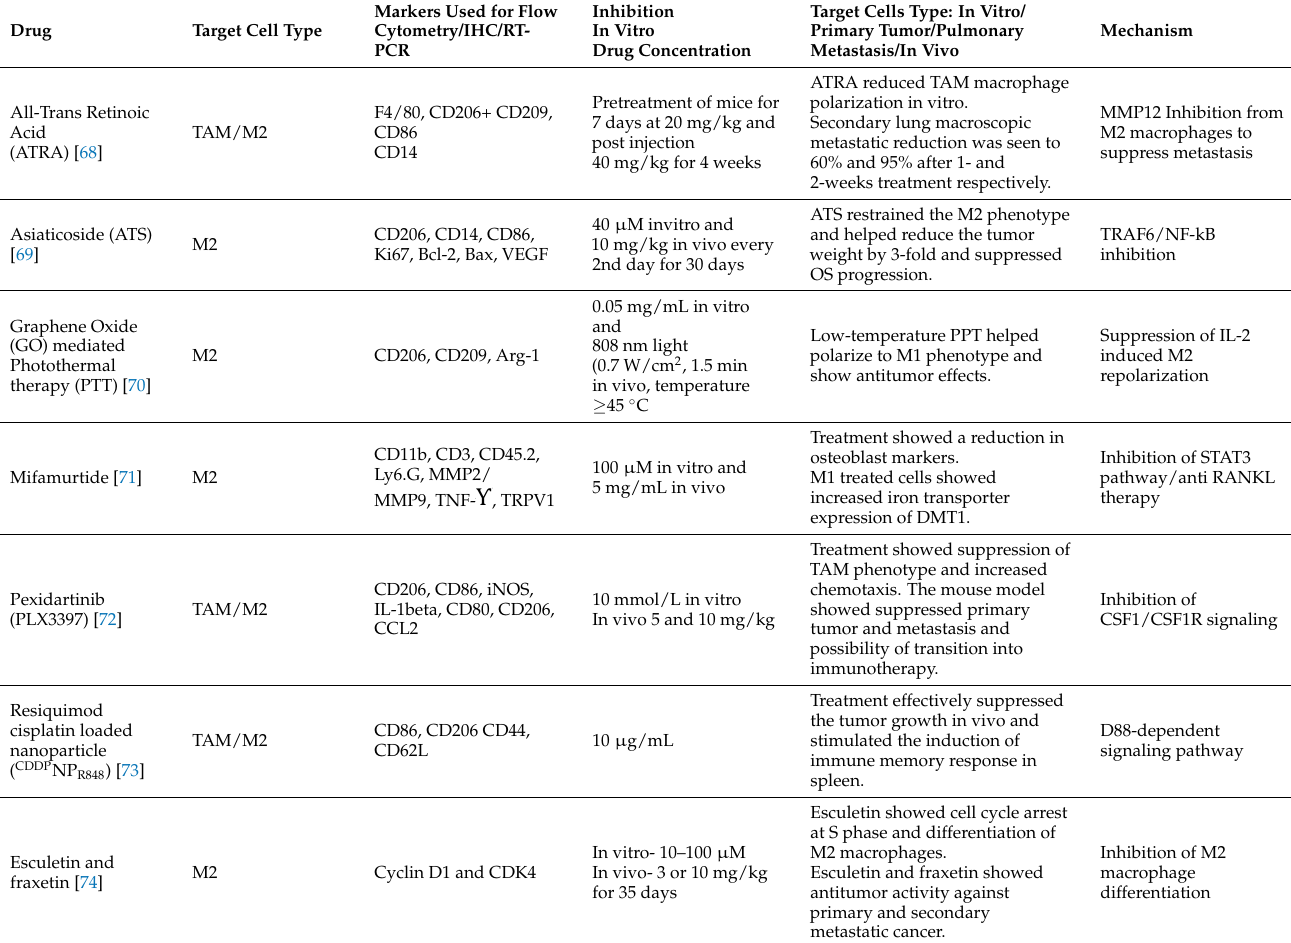
Table 2. Drugs targeted against TAM/M2 macrophages using in vitro and in vivo